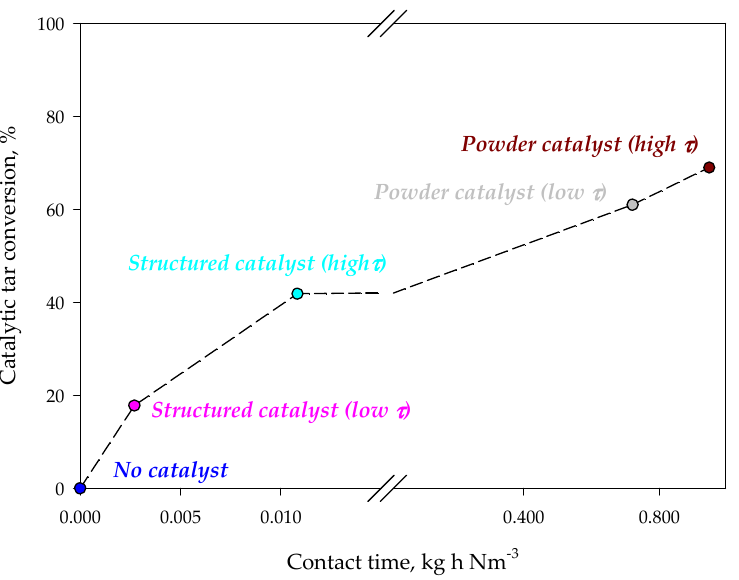
Figure 4. Catalytic tar conversion as a function of the contact time during standard and enhanced gasification tests.